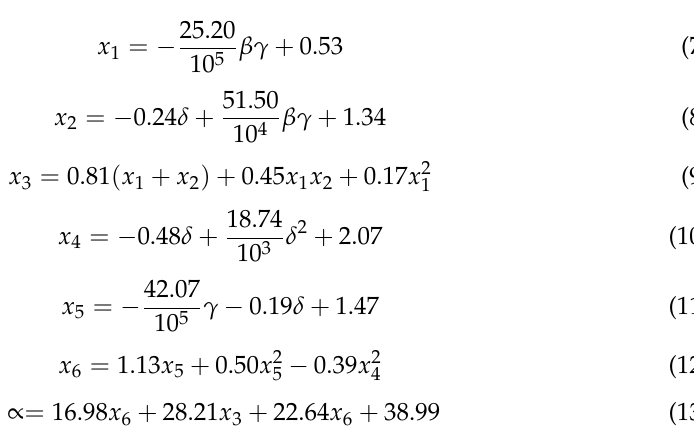
Table 3. Quartiles border values.